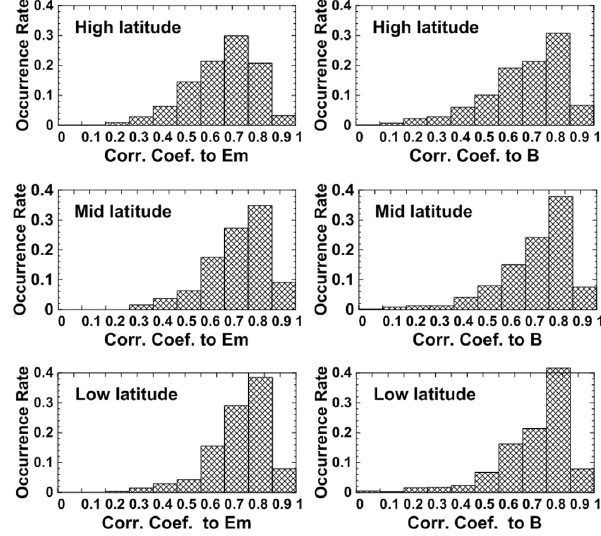
Fig. 8. Same as Fig. 7, but for different latitude